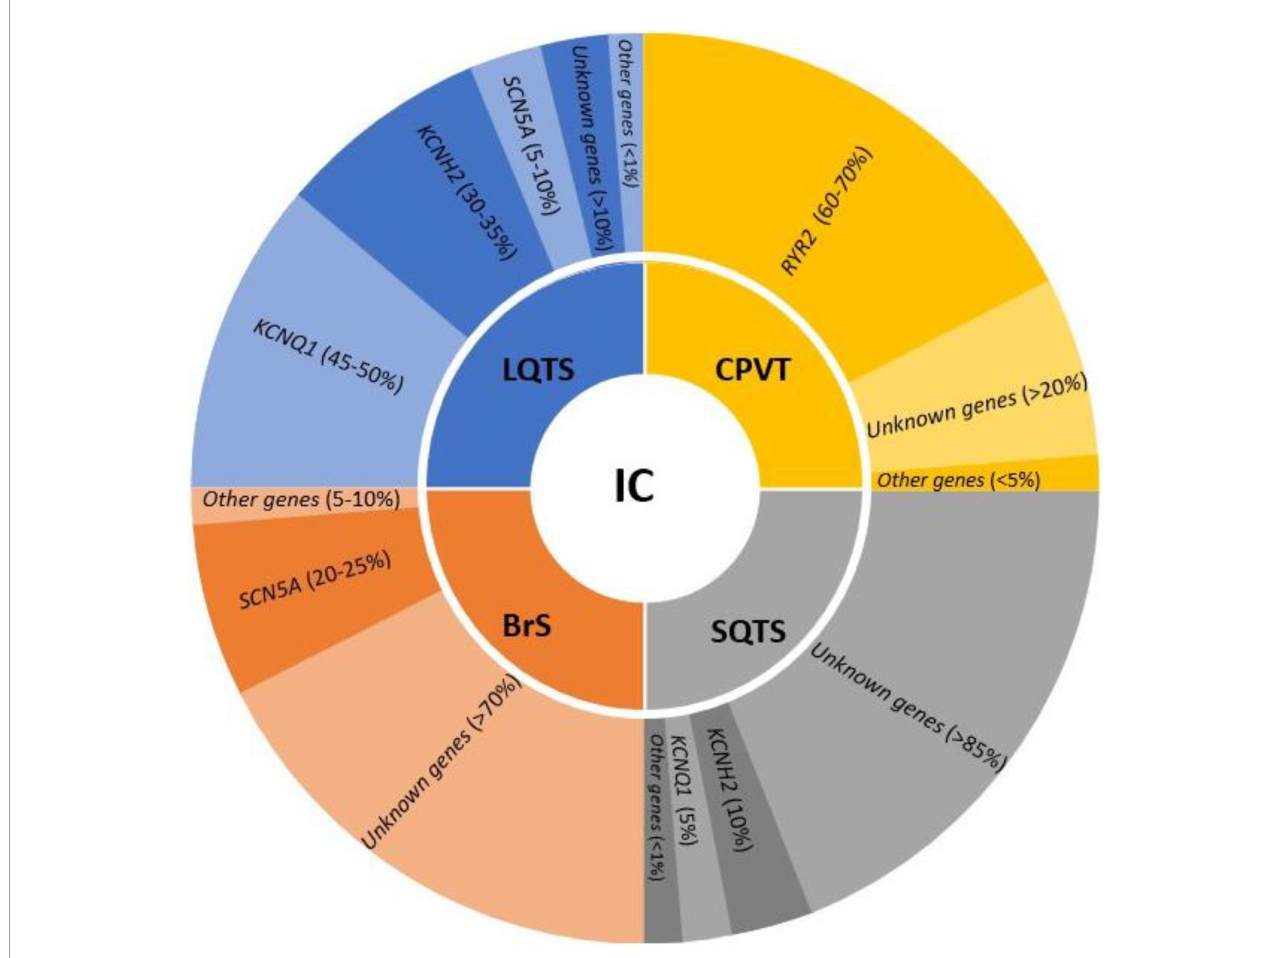
FIGURE1 Genes involved in the main inherited channelopathies (IC) and their frequency in each syndrome. LQTS, long QT syndrome; CPVT, catecholaminergic polymorphic ventricular tachycardia; SQTS, short QT syndrome; BrS, Brugada